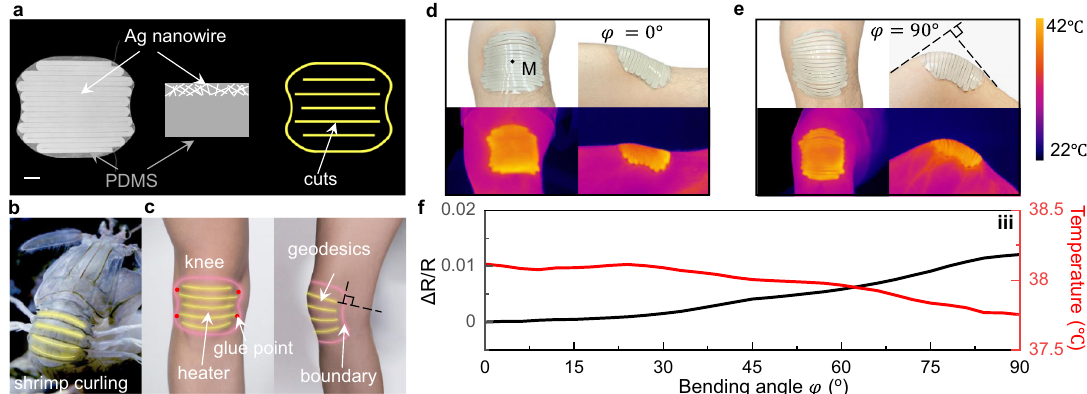
Fig. 8 Dynamically conformable biomimetic heater. a Photograph of the 2D precursor. Scale bar: 10 mm. The right shows the schematics of the cross- section of the AgNW/PDMS heater and the cut pattern. b , c Schematics of the heater mimicking the shell of the Mantis shrimp composed of geodesics attached to the human knee. b Curling shell of the Mantis shrimp. Yellow lines represent geodesics. c Schematic of the heater attached to the knee. Pink and yellow lines are the boundary and the geodesics, respectively. Red dots are the points with the adhesive. Black dashed lines representing the geodesics are perpendicular to the boundary with the knee bending. d , e The kirigami heater deforms with the knee as the knee bends from 0° ( d ) to 90° ( e ) and the corresponding thermal image upon heating. φ denotes the bending angle of the knee. M is the center of the knee. The color bar represents the temperature. f Electric resistance of the heater and the temperature of the point M as a function of the bending angle φ